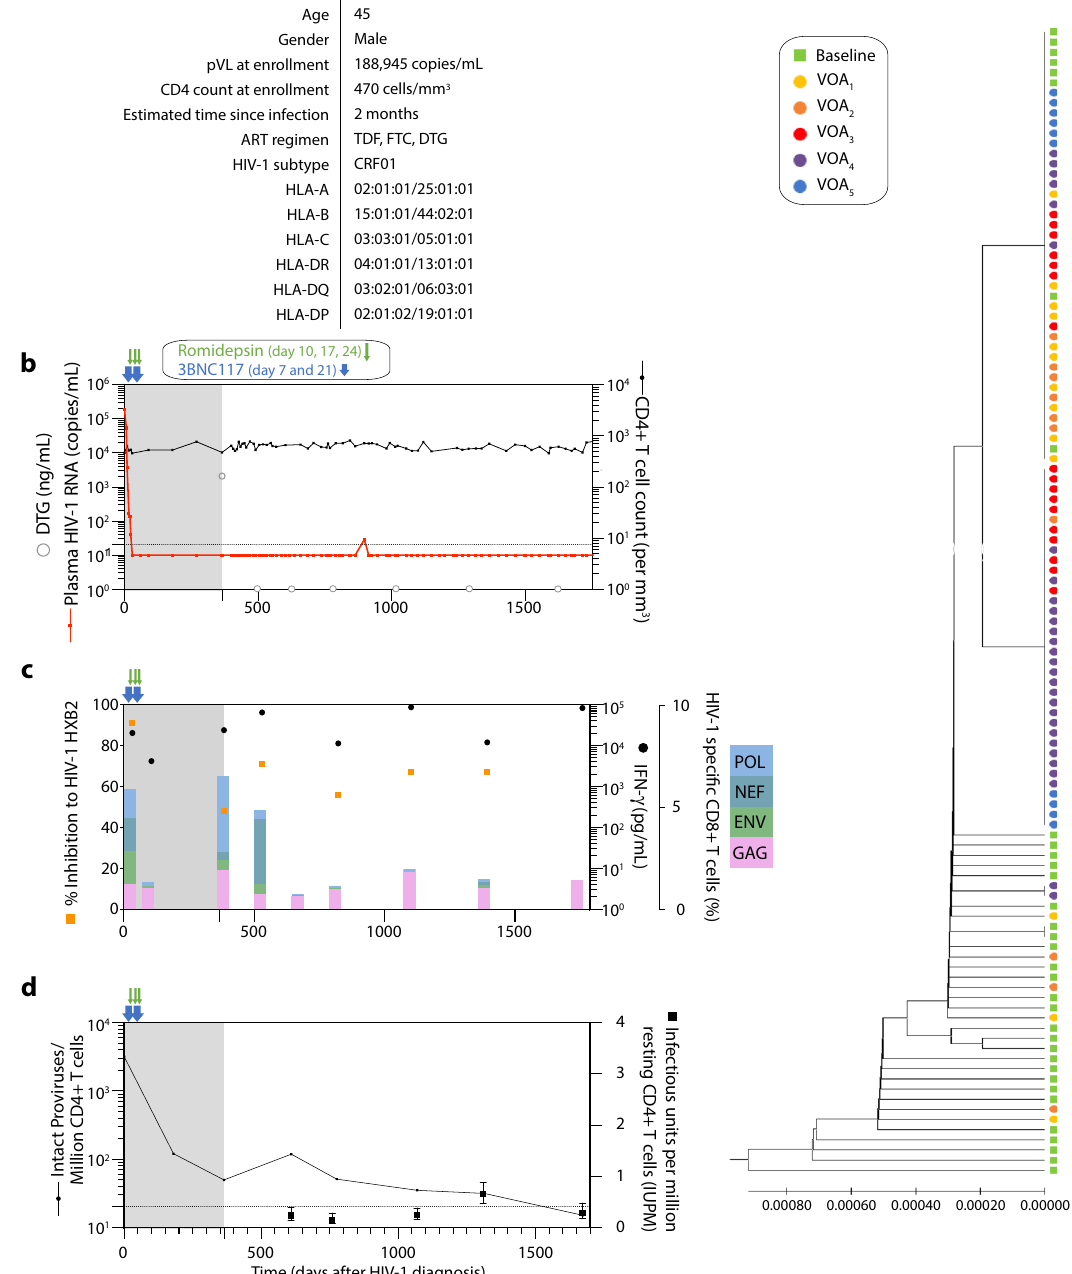
Fig. 5 | Clinical and immunological characteristics of ID107. a Clinical char- acteristics for ID107: age, gender, plasma viral load and CD4 count at enrollment, estimated time since infection, ART regimen, HIV-1 subtype and HLA typing. b Plasma HIV-1 RNA levels (copies/mL) and CD4+ T cell counts are shown long- itudinallyovertheperiodoftheinterventional(grayarea)andART-free(whitearea) period. Time points for measurement of the concentration of dolutegravir (DTG) (ng/mL) shown as gray circles over time. c Frequency of HIV-1-speci fi c CD8 + T cell responsesto HIV-1 Env, Gag,Poland Nef detected by the AIMassay shown ascolor